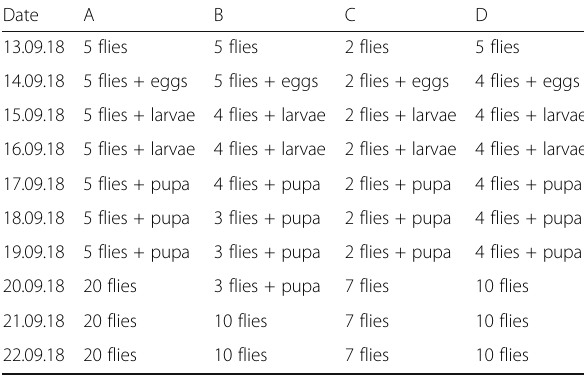
Table 2 Culture of flies in 0.8 ppm NaF in four different